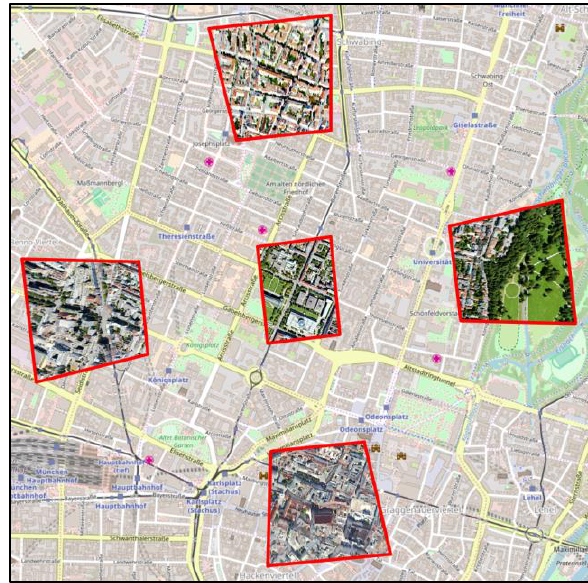
Figure 1. Example of Leica CityMapper-2S nadir and oblique ground coverage from one image take. Image data was captured over Munich, Germany, in 2021 (see also chapter 4).